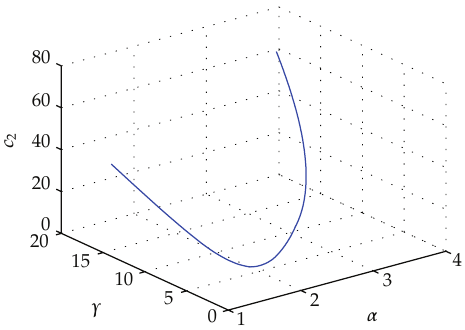
Figure 1: The local optimal bound of γ and c 2 .